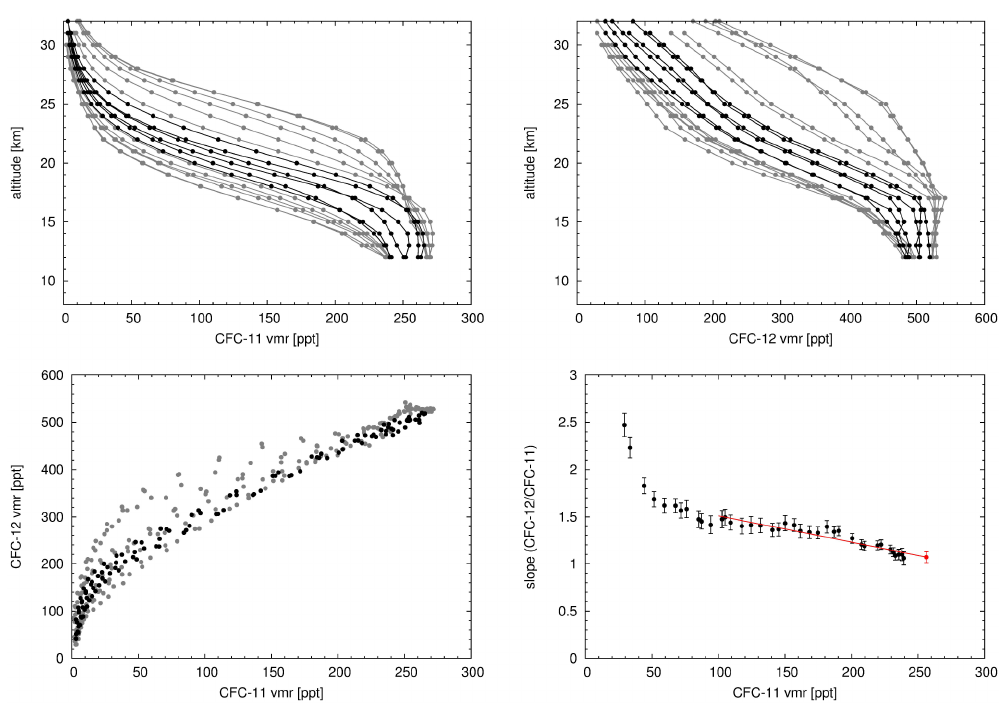
Figure 6. Same as Fig. 4, but for MIPAS